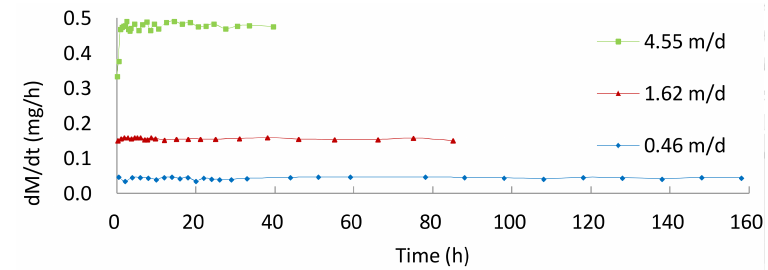
Figure 5. Mass deposition rate (slope of the curves from Figure 4).